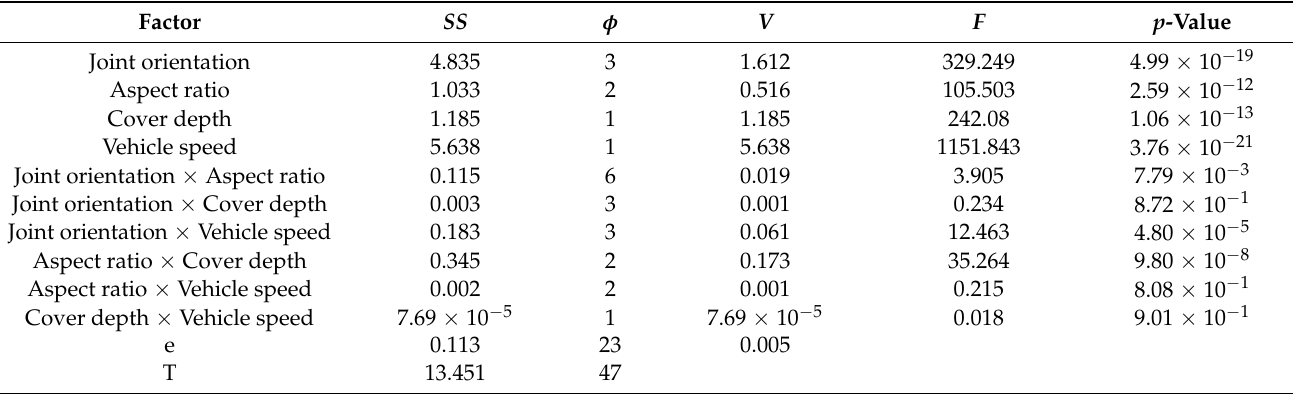
Table 9. ANOVA table after three-factor interaction